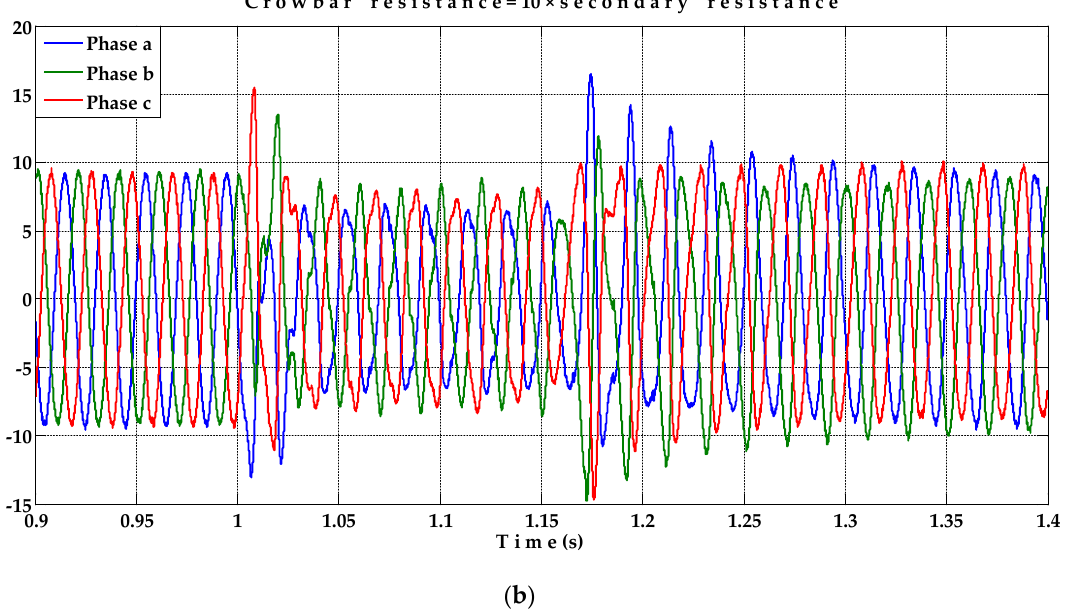
Figure 18. Primary current of BDFRG without and with the proposed crowbar protection under single-line to ground fault: ( a ) Without the proposed crowbar; ( b ) With the proposed crowbar. The dc link voltage of the BDFRG (with and without using the proposed crowbar) is shown in Figure 20, which has a reference value equal to 710 V. Under the fault occurrence, in the case of “without using the proposed crowbar”, the dc link voltage was decreased to about 642 V. In the case of using the proposed crowbar, the dc link voltage increased to about 800 V, but with damped oscillations than in the other case, then the dc link voltage improved and returned to its pre-fault value.